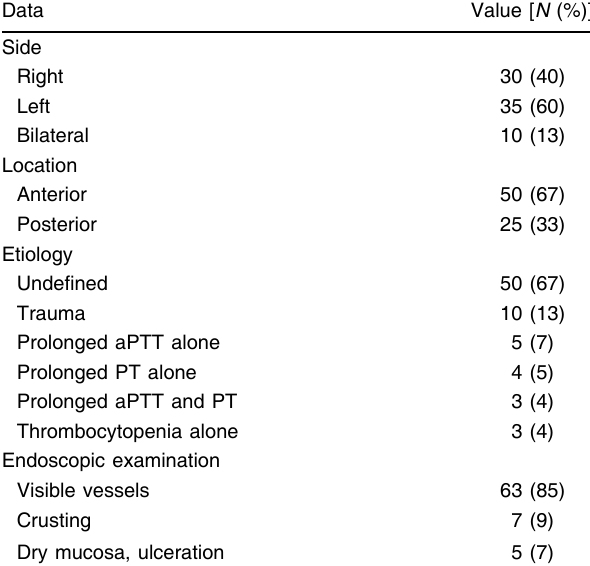
Table 2 Features of epistaxis